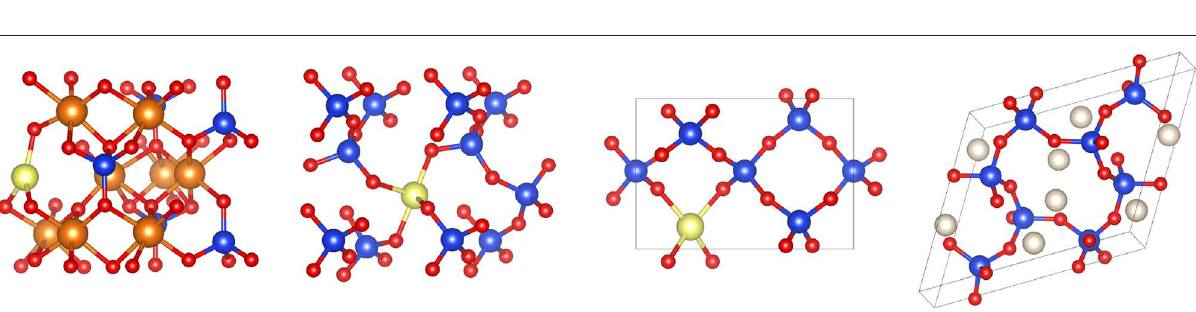
from He to surrounding atoms. Excess primordial He (i.e.,